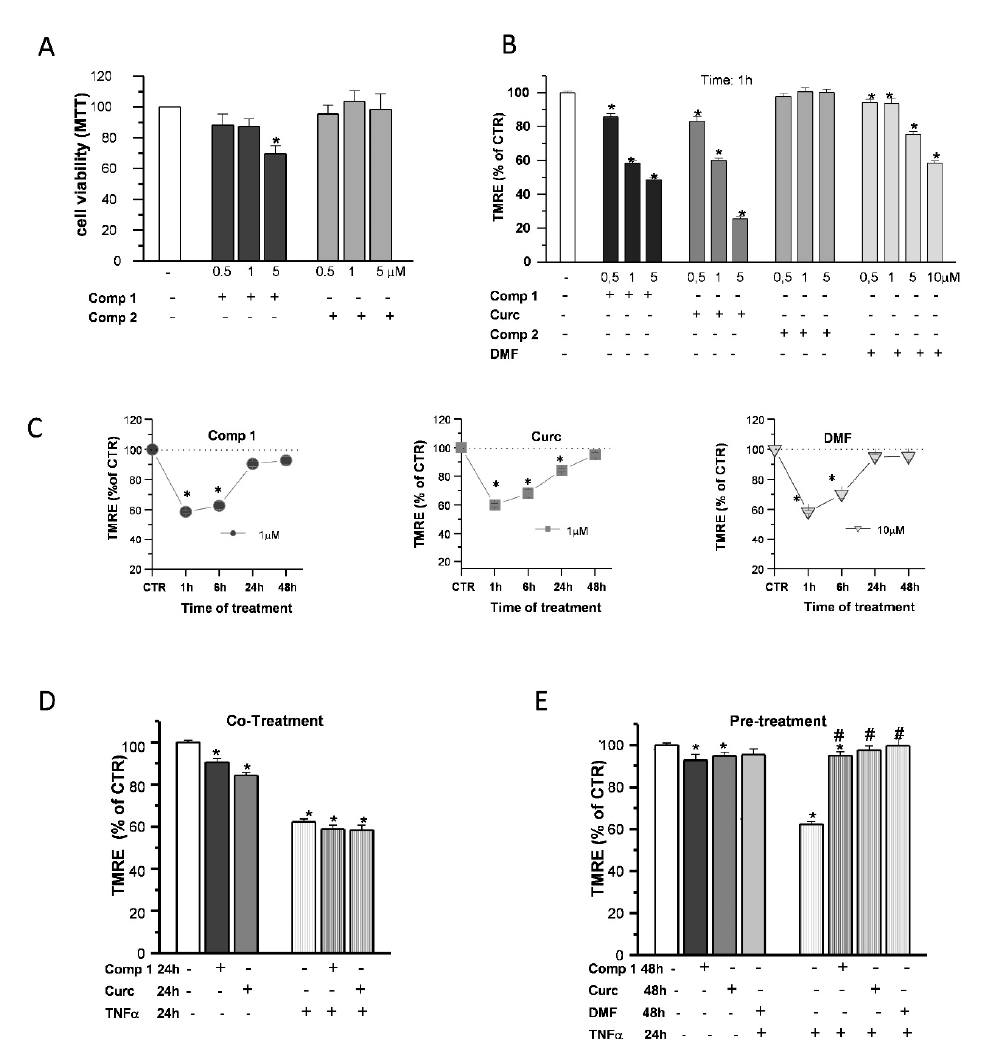
Figure 7. E ff ects of hybrids on the mitochondria. OP cultures were treated for 24 h with di ff erent Figure 7. Effects of hybrids on the mitochondria . OP cultures were treated for 24 h with different concentrations (0.5, 1, and 5 µ M) of the synthetic compounds, and cell viability was determined by concentrations (0.5, 1, and 5 µM) of the synthetic compounds, and cell viability was determined by 3- 3-(4,5-dimethyl thiazol-2-y1)-2,5-diphenyl tetrazolium bromide (MTT) assay ( A ). TMRE